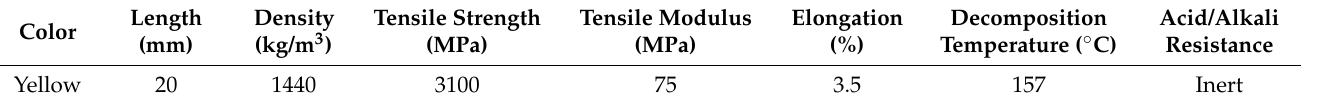
Table 4. Characteristics of aramid